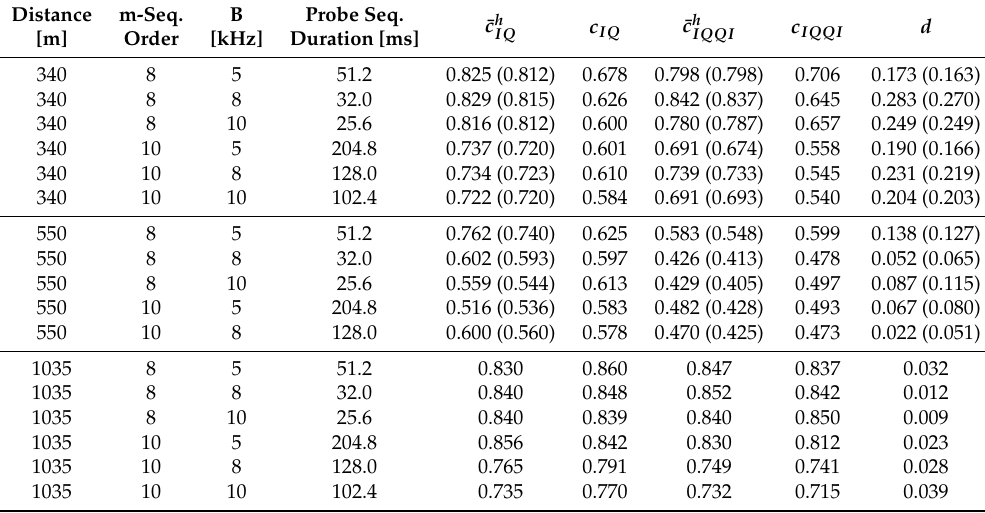
Table 2. Results of inland-water experimental tests